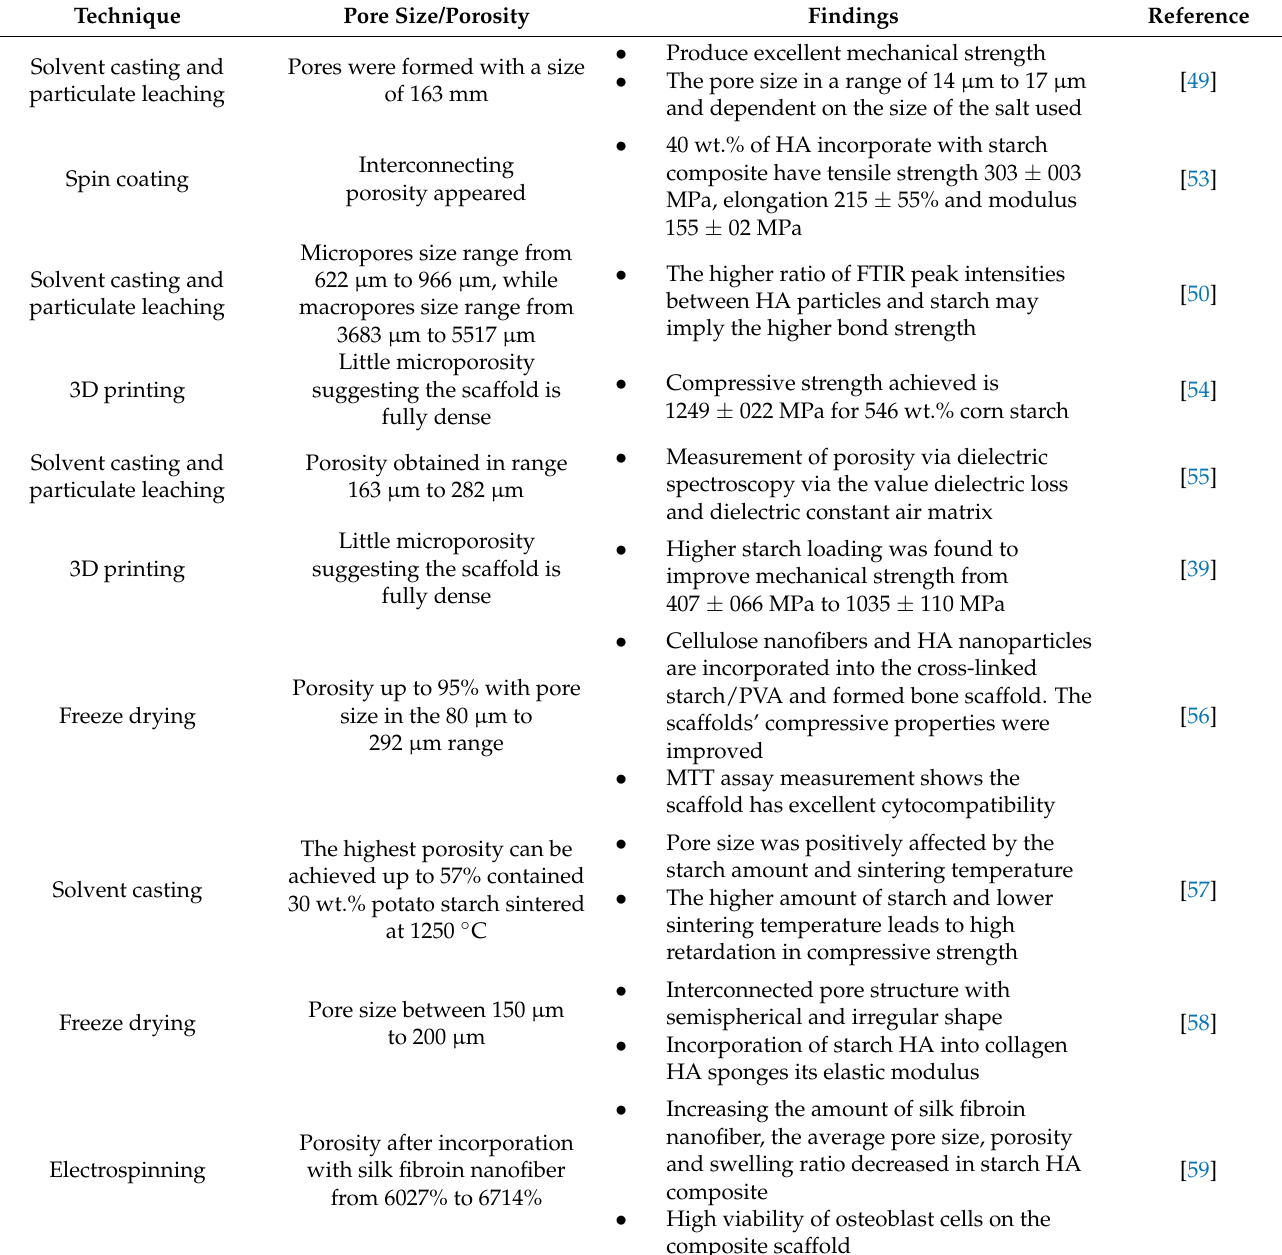
Table 1. Research on starch/hydroxyapatite (HA) composite scaffold.